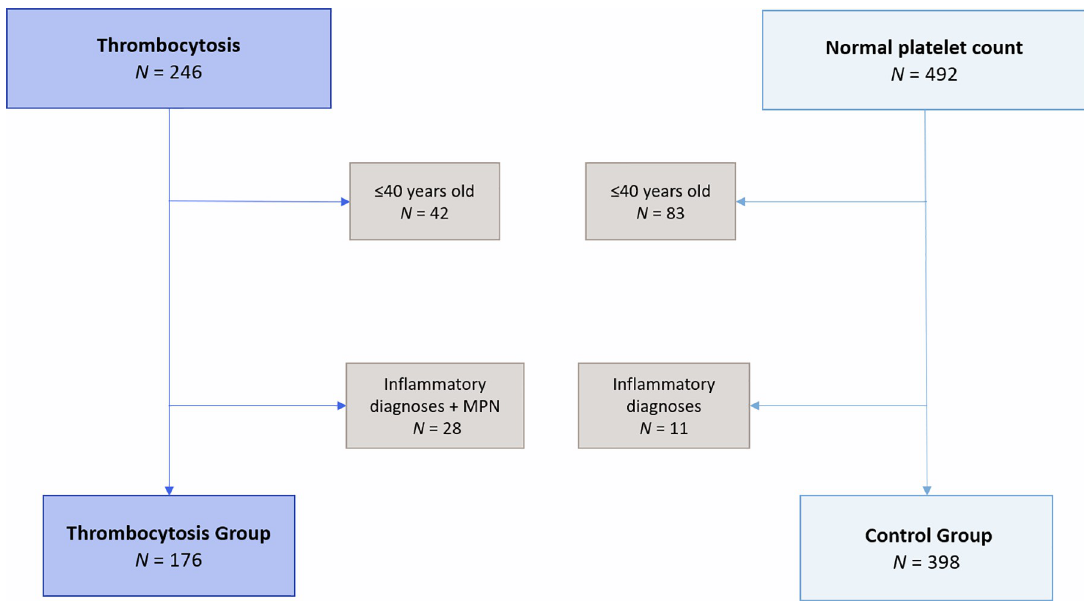
Fig 1. Patient flow diagram of exclusion criteria being applied to thrombocytosis group and control group. MPN, myeloproliferative neoplasm.